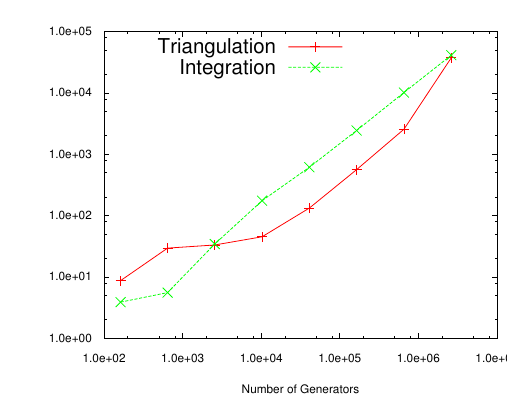
Fig. 6. Timings for STRIPACK-based SCVT construction for var- ious generator counts. Red solid lines represent the time spent in STRIPACK computing a triangulation whereas green dashed lines represent the time spent integrating the Voronoi cells outside of STRIPACK in one iteration of Lloyd’s algorithm.